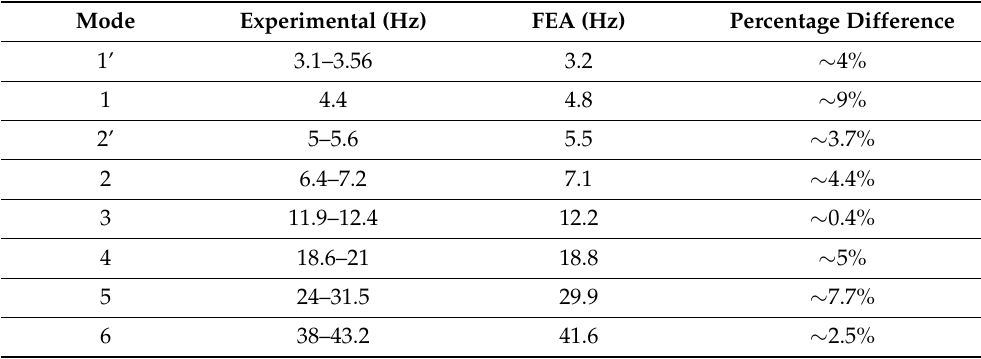
Table 5. Comparison of Natural Frequencies Obtained from Experimental and Finite Element Analysis.